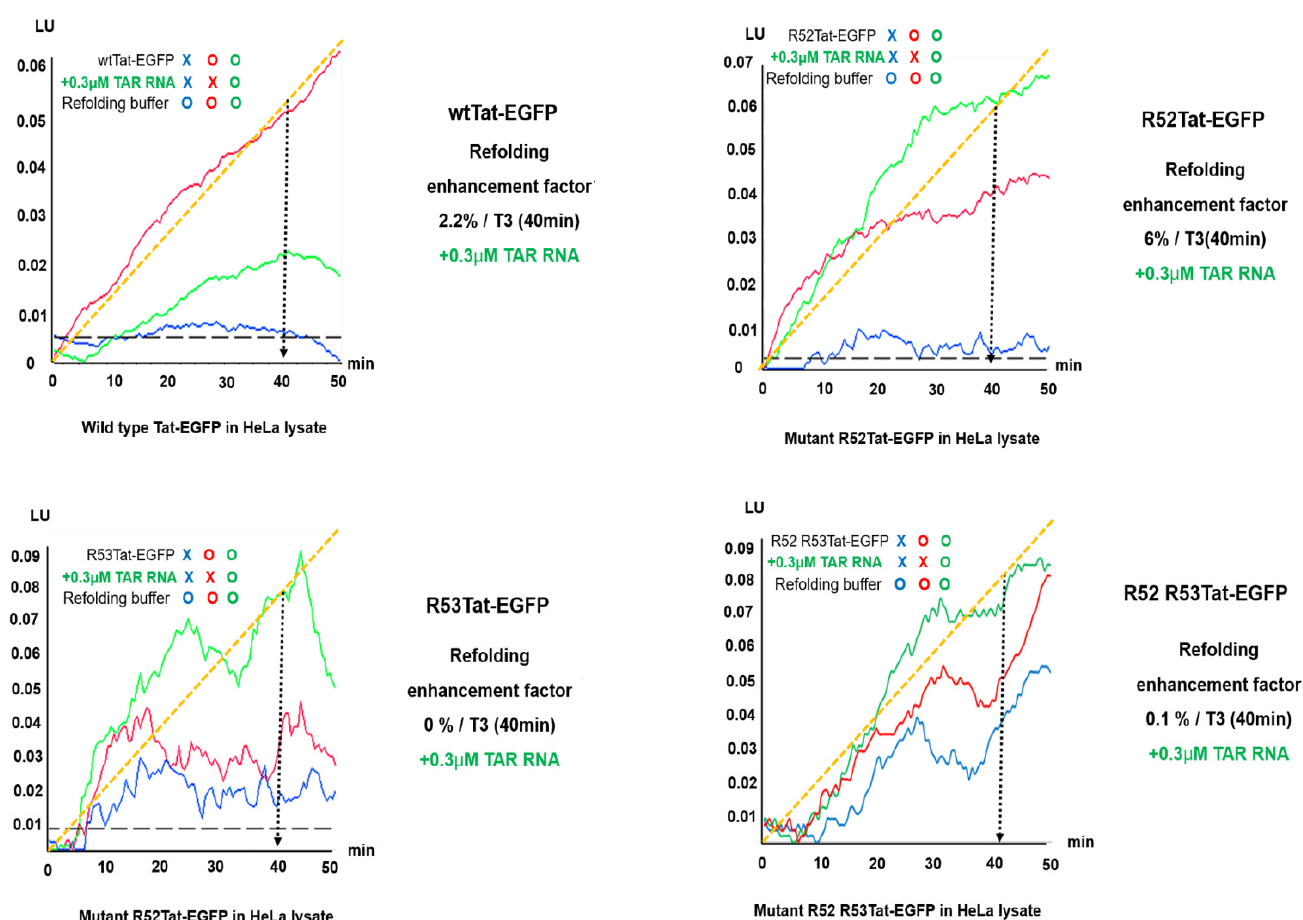
Figure 3. Comparative kinetic analysis of the refolding of mutants R52, R53, and R52R53Tat-EGFP in the presence of TAR RNA. The refolding enhancing factor was measured via the fluorescence of wild-type/mutant R52Tat–EGFP in the presence of 0.3 µ M TAR RNA in HeLa lysates. The increase in the fluorescence intensity of EGFP was monitored by the time-dependent increases in the fluorescence of wild-type Tat-EGFP and mutant Tat-EGFP. In the presence of 0.3 µ M TAR, it was possible to observe refolding enhancement factors over the time course of the fluorescence intensity. A refolding enhancing factor for R52Tat fusion EGFP in the absence or presence of TAR RNA in 0.3 µ M HeLa cell lysate of ~6% at 40 min is shown by the green line. Refolding enhancing factors of R53 and R52R53Tat fusion EGFP in the absence or presence of TAR RNA in 0.3 µ M HeLa cell lysate of ~1% and 0% at 40 min are shown by the green line. The refolding enhancing factor of wild-type Tat fusion EGFP in the absence or presence of TAR RNA in 0.3 µ M HeLa cell lysate of ~2.2% at 40 min is shown by the green line. All the data are the averages of duplicate experiments. Color plots represent the data ranges via linear fitting. EGFP emissions are given in relative light units (LU). Refolding buffer baselines were subtracted from all the